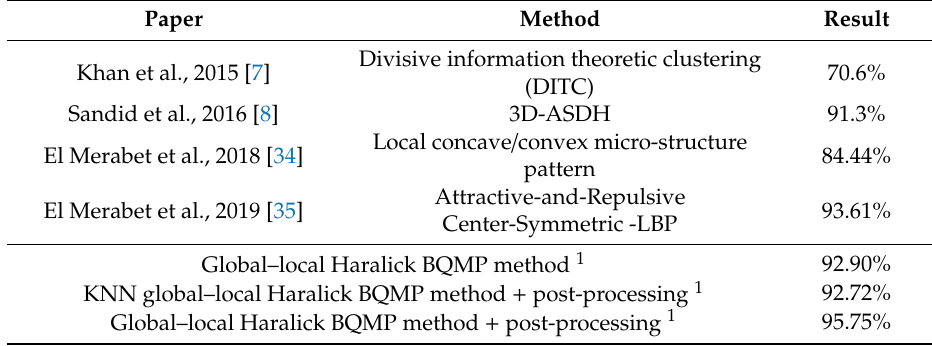
Table 8. Best results of global–local Haralick–BQMP classification for the KTH-TIPS2b database with 1188 images per set and the best previously published results on the same database.